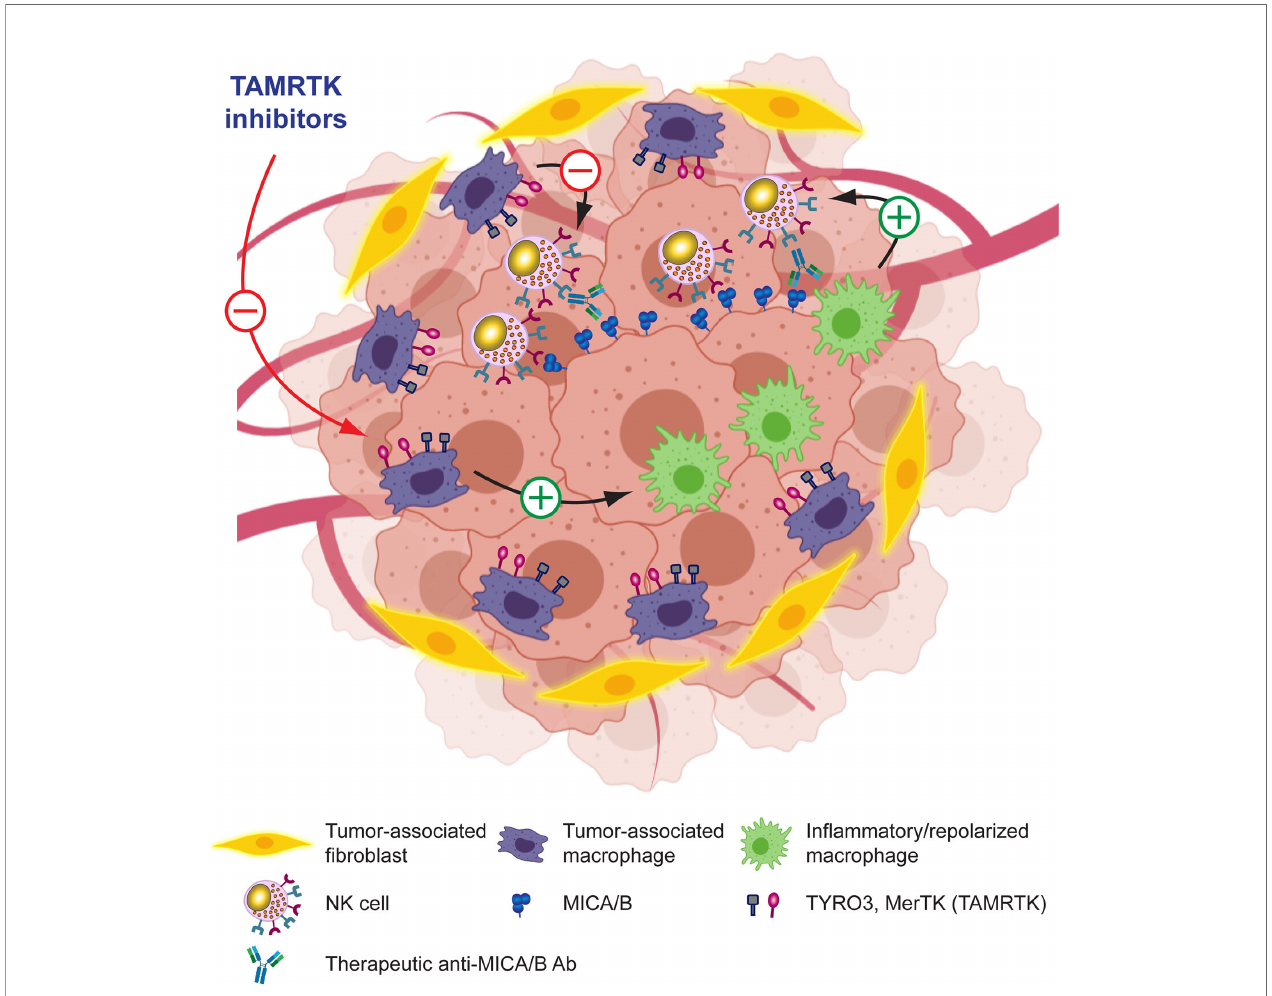
FIGURE 7 | Leveraging anti-MICA/B Ab therapeutic ef fi cacy through combination therapies with molecules that target TAM. Pharmacologic blockade of receptors involved in TAM-mediated immunosuppression in the TME may promote reprogramming of TAM into pro-in fl ammatory macrophages and a subsequent remodeling of the TME. These pro-in fl ammatory macrophages, instead of inhibiting NK cells, might now promote ef fi cient NK cell effector functions such as improved CD16- dependent ADCC of anti-MICA/B Ab, and a recovery of NKG2D-dependent NK cell-mediated cytotoxicity against tumor cells. Together, these effects may contribute to foster an ef fi cient tumor cell